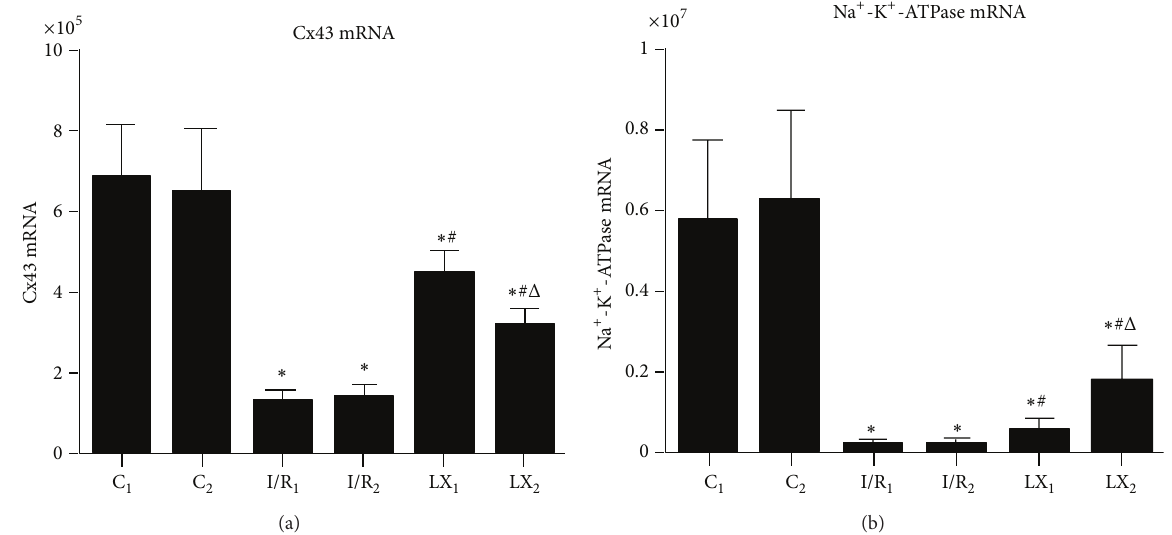
Figure 5: mRNA levels of Cx43 and Na + -K + -ATPase of cardiac tissues from rats of different groups at T 2 . Samples were collected right after I/R procedure. (a) Cx43 mRNA; (b) Na + -K + -ATPase mRNA. ∗ 𝑃 < 0.05 for comparisons of I/R 1 and LX 1 groups with C 1 group, 𝑃 < 0.05 for comparisons of I/R 2 and LX 2 with C 2 group; # 𝑃 < 0.05 for comparisons of LX 1 group with I/R 1 group, 𝑃 < 0.05 for comparisons of LX 2 group with I/R 2 group; Δ 𝑃 < 0.05 for comparisons of LX 2 group with LX 1